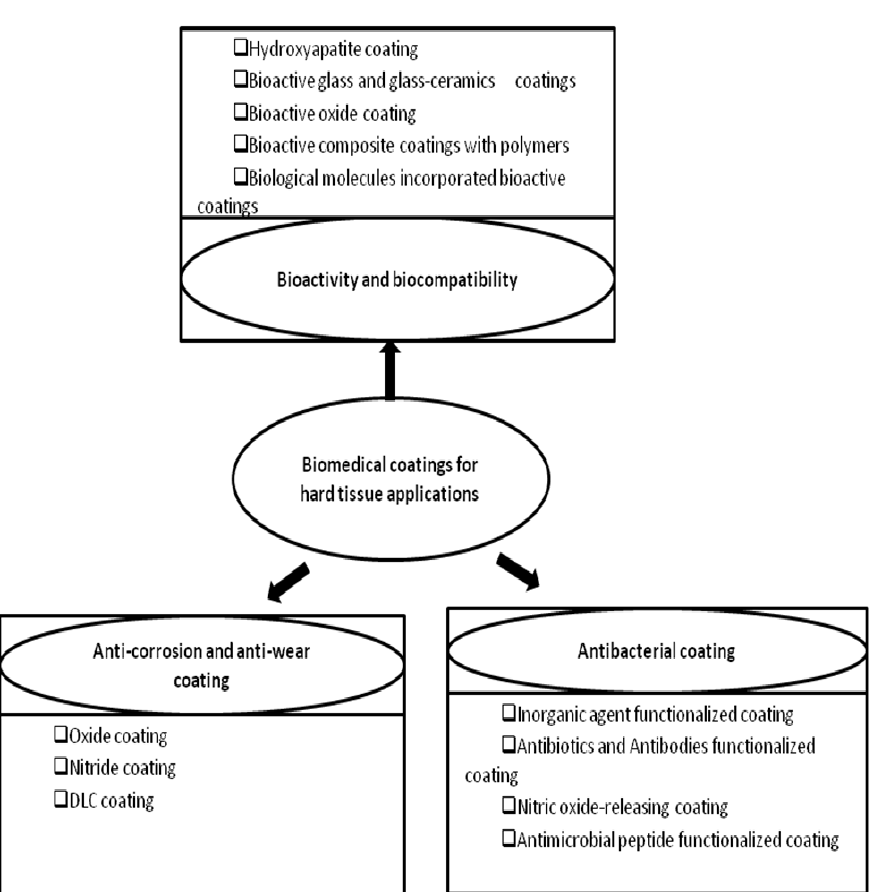
Figure 1. The outline of this review